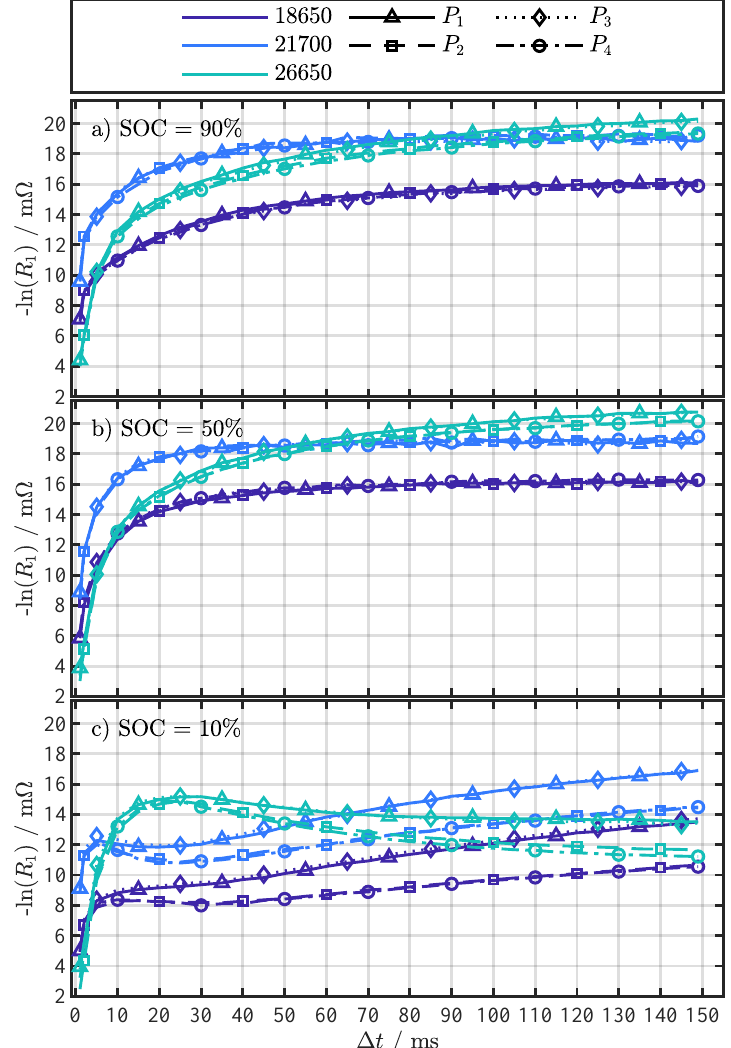
Figure A4. Fitting results for Equation (4) for the parameter R 1 , each investigated cell format, and the four different pulse current types ( P 1 to P 4 ) at the SOCs 90% ( a ), 50% ( b ), and 10% ( c